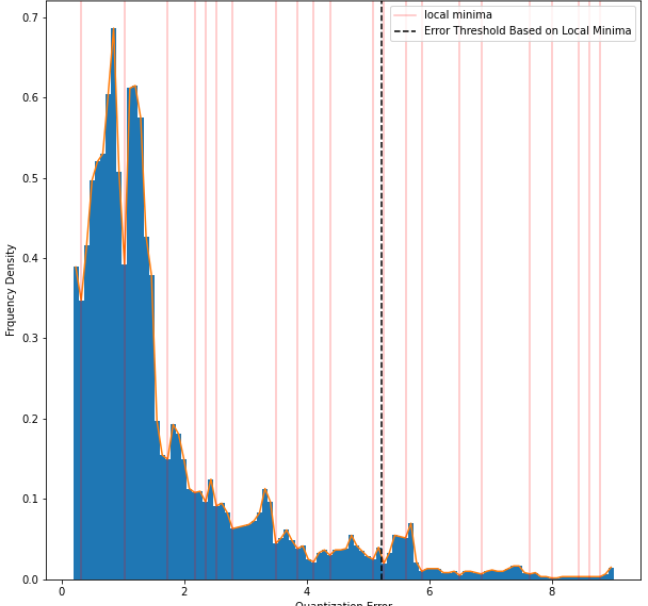
Figure 8. Error threshold assignment from quantization error distribution using local minima.